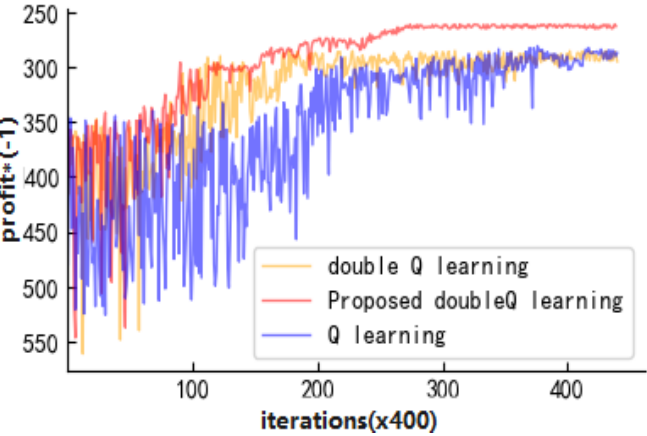
Figure 11. Learning effect of different algorithms.